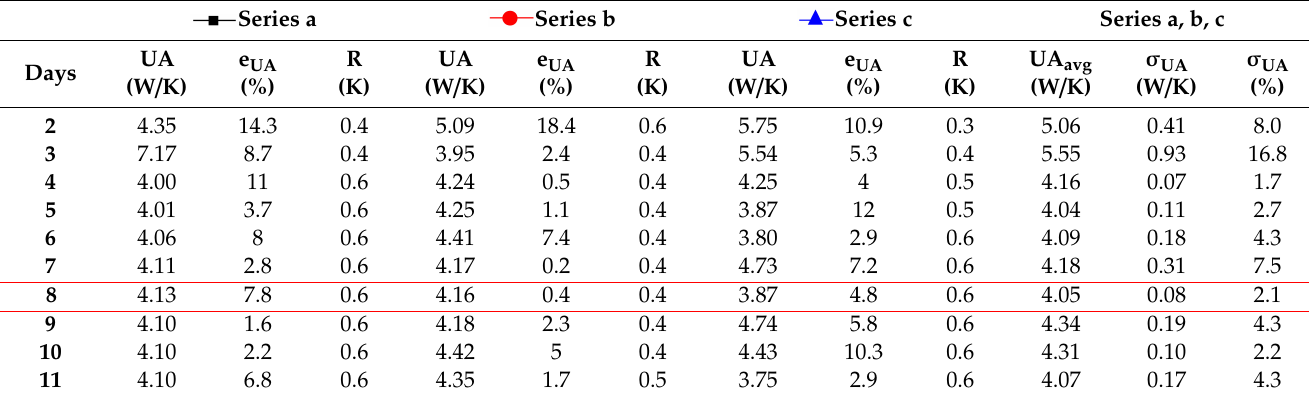
Table 12. Whole building. Comparison of the results for di ff erent test lengths. UA for the 3 nodes model with solar radiation and T i as output.